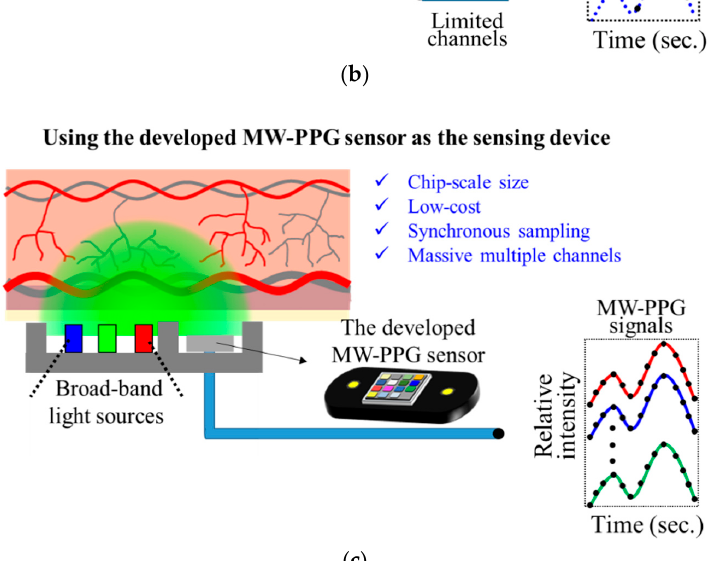
Figure 1. Illustration of multi-wavelength photoplethysmography (MW-PPG) sensing technologies: ( a ) prior works using a conventional spectrometer as the sensing device; ( b ) prior works using a photodiode as the sensing device in sequential sampling architecture; ( c ) the proposed work using the developed chip-scale MW-PPG sensors as the sensing device. In this study, we developed a chip-scale MW-PPG sensor using innovative an on-chip 75 spectrometer approach, as shown in Figure 1c. The MW-PPG sensor developed is only several square 76 micrometers. It is compact, robust, and lightweight. To provide a large number of PPG signals at 77 different wavelengths, only one broad spectrum light-emitting diode ( LED ) or a few LEDs covering 78 broad spectrum are required. Furthermore, signal processing algorithms were developed to robustly 79 extract PPG signals using this developed MW-PPG sensing device. Experimental results show that 80 the S/N of the maximal-ratio combined (MRC) MW-PPG signals, namely MRC-MW-PPG signals, can 81 be increased by up to 50%, compared to those acquired from the conventional single wavelength 82